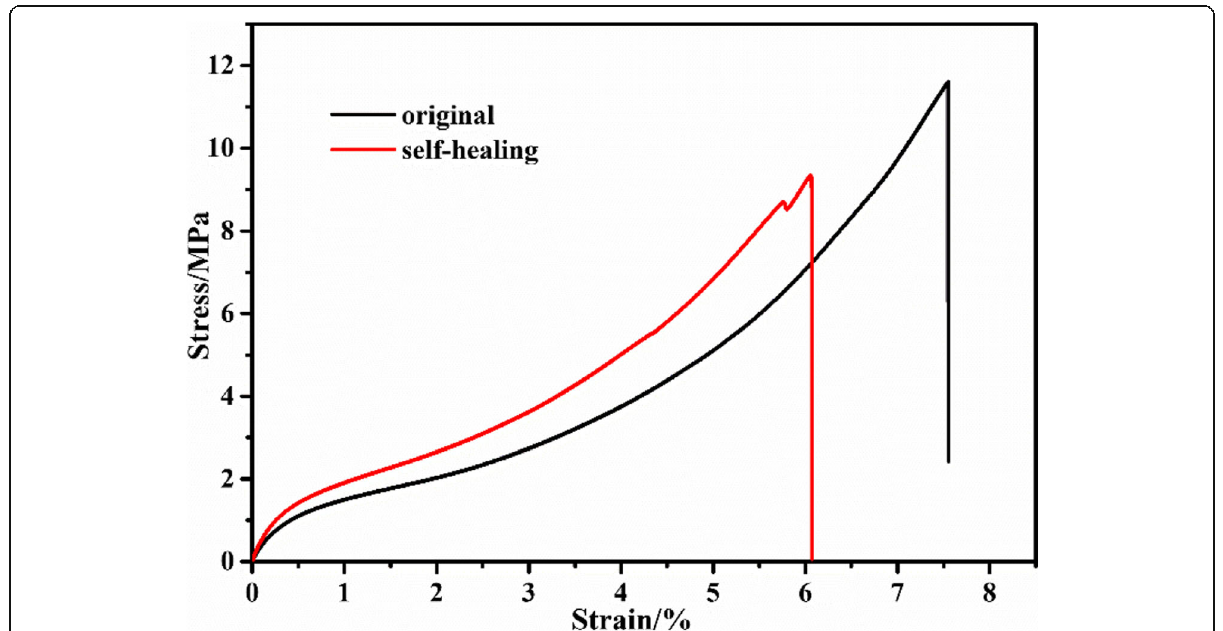
Fig. 3 Comparison of mechanical properties of polyurethane original and